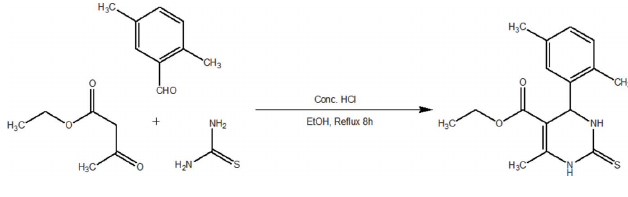
Figure 3 The reaction scheme for the preparation of the title compound.